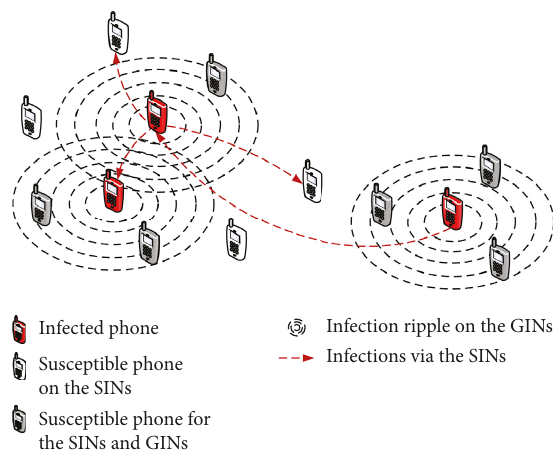
Figure 1: The hybrid spreading behavior of the mobile Internet